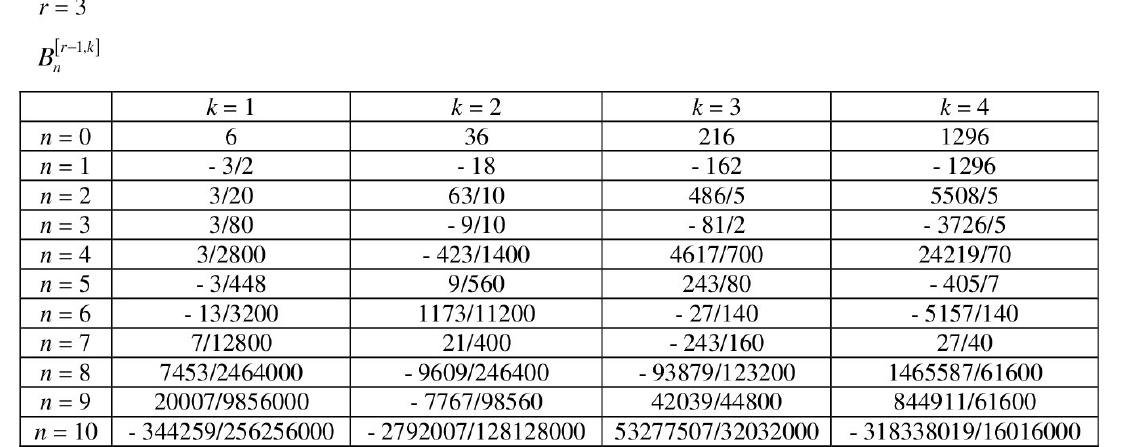
Figure 1. Numbers B